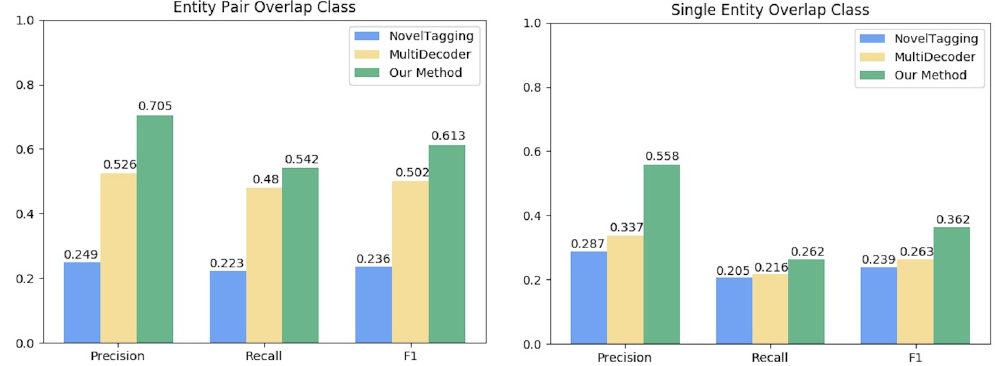
Figure 2. Results of our model and baseline models in Entity Pair Overlap class and Single Entity Overlap class in NYT10 dataset.